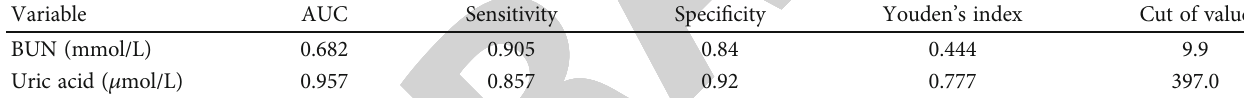
Table 4: Cut o ff value determination for uric acid and bun to discriminate